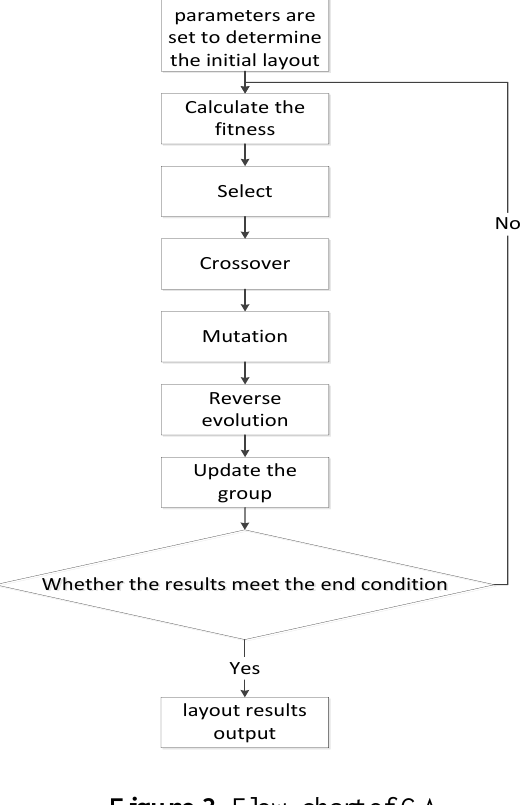
Figure 3. Flow chart of